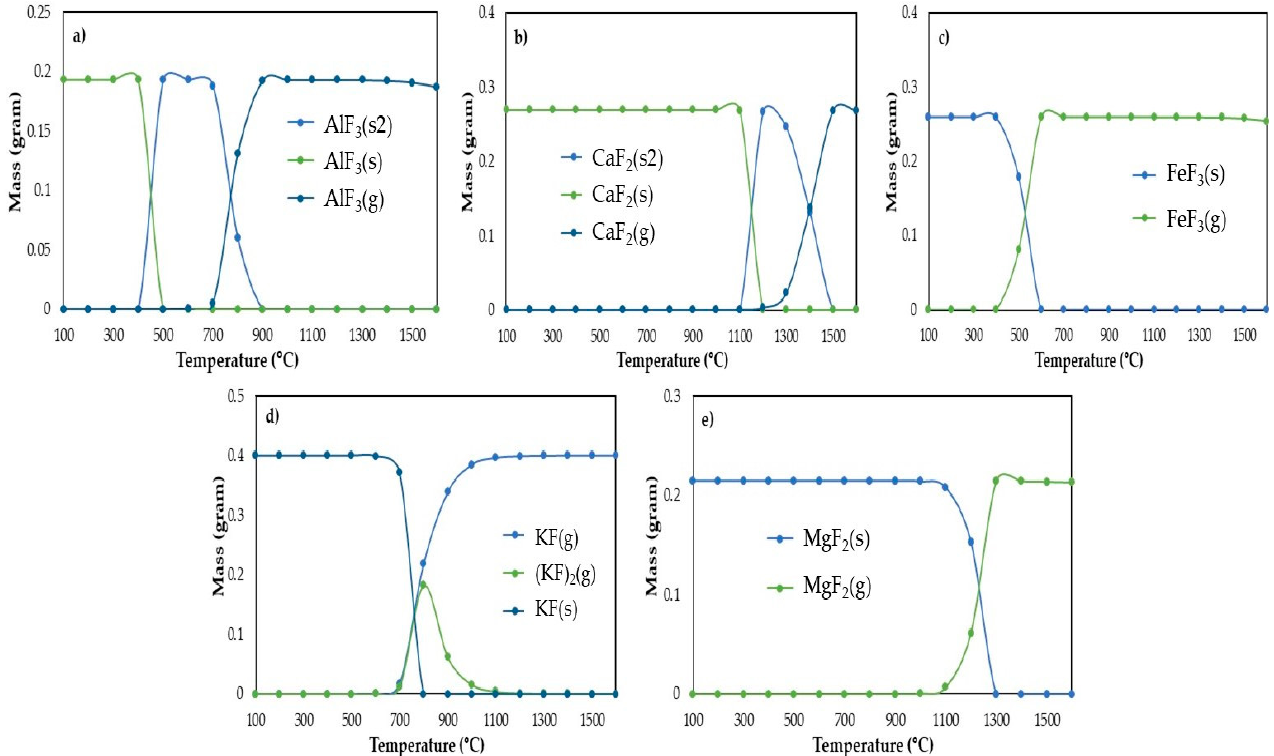
Figure 3. Equilibrium composition of Cr-Mineral oxides interactions during combustion: ( a ) Cr-O 2 -Al 2 O 3 ; ( b ) Cr-O 2 -CaO;